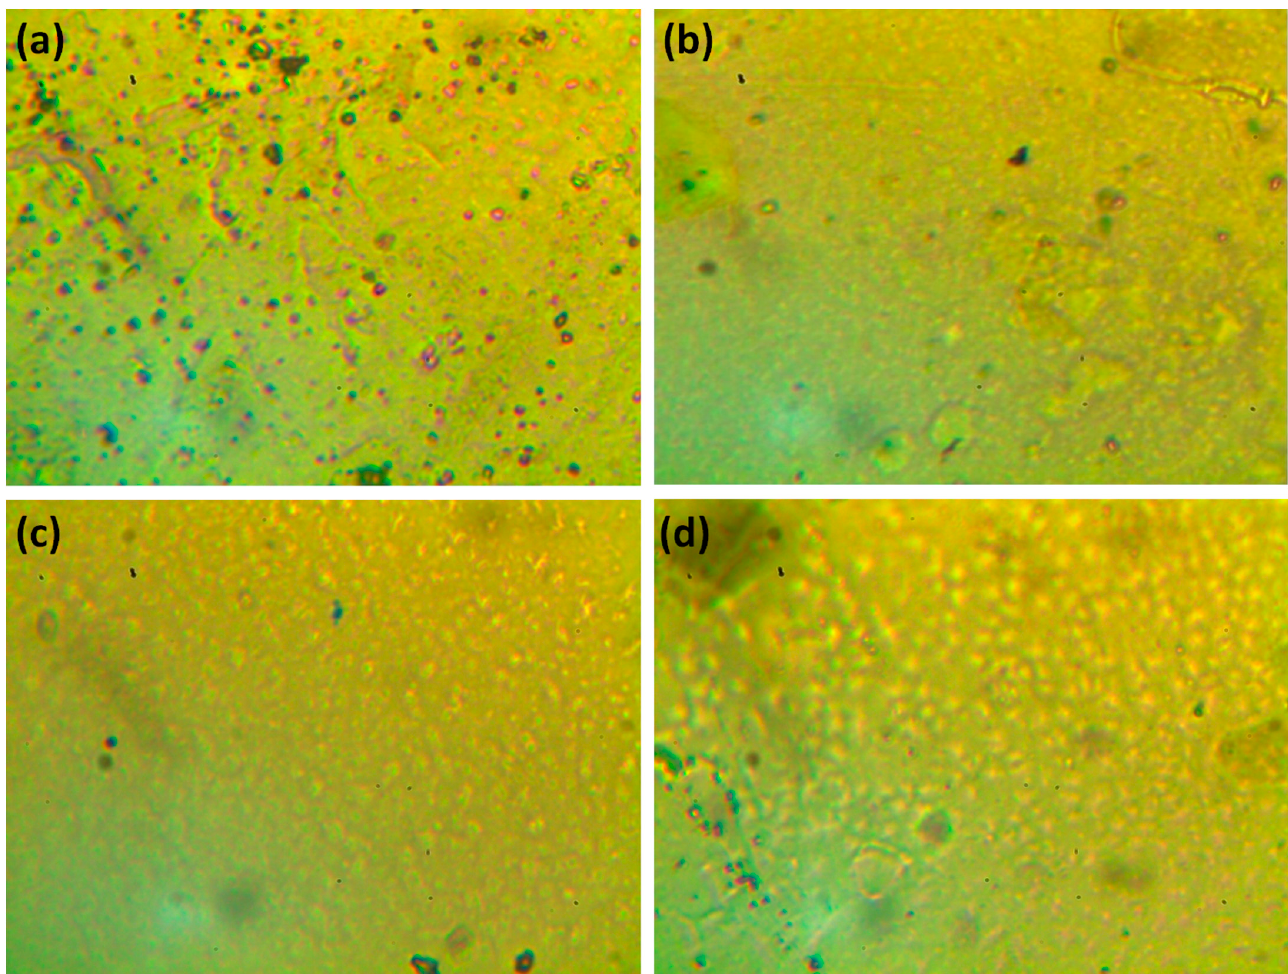
Figure 5. Microscope images (400× magnifications) of irradiated ( a ) pure PVC, ( b ) PVC + 1 , ( c ) PVC + 2 , and ( d ) PVC + 3 .